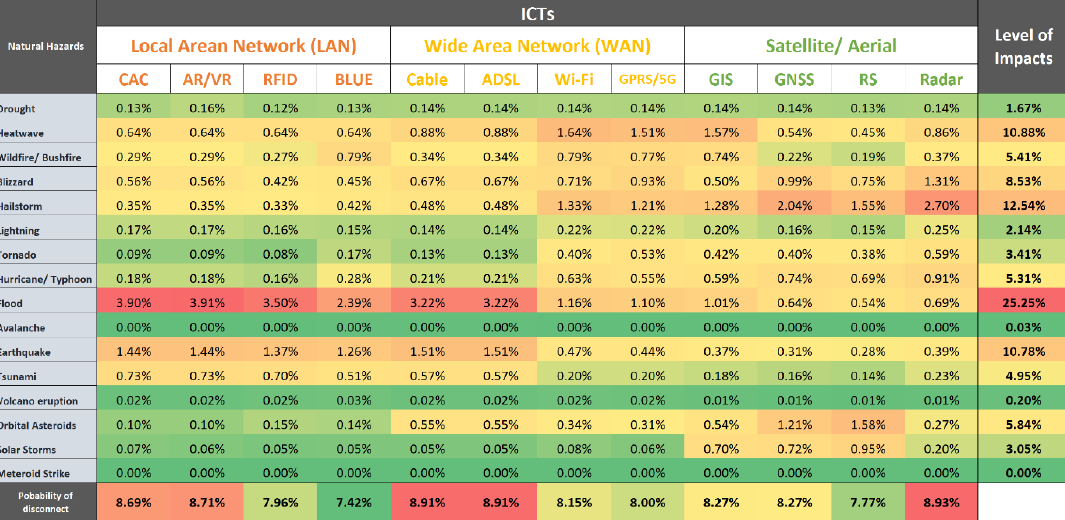
Figure 7. Impacts of natural hazards on the ICTs.